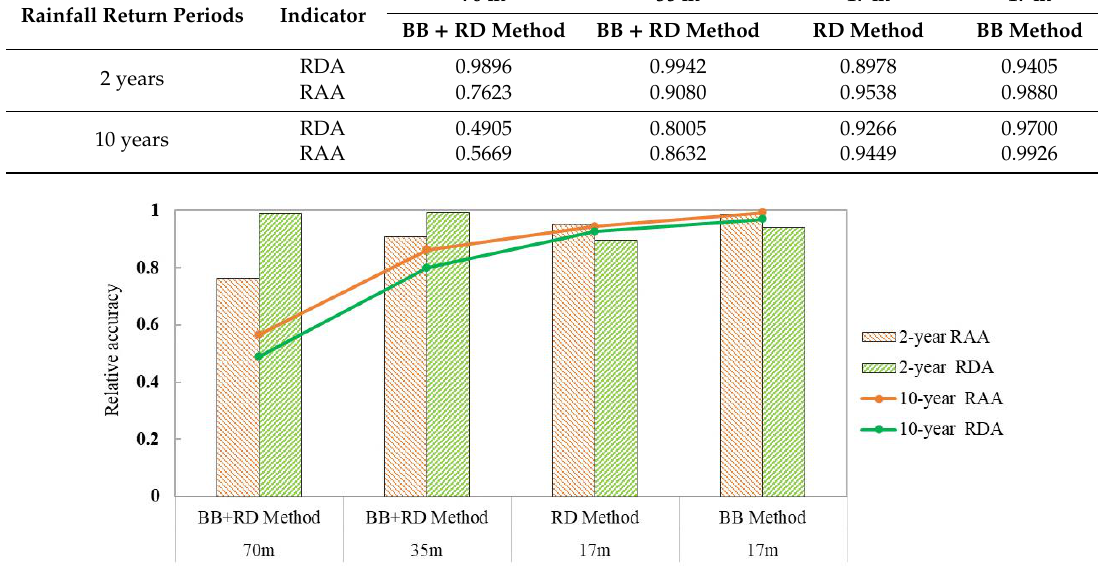
Figure 15. The relative accuracy indicators for all simulation cases.